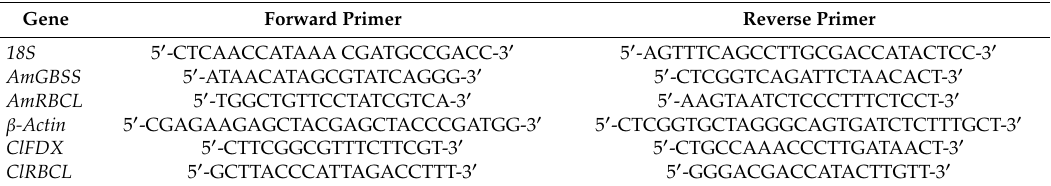
Table 3. The primer sequence used in this study to measure the gene expression using quantitative real-time